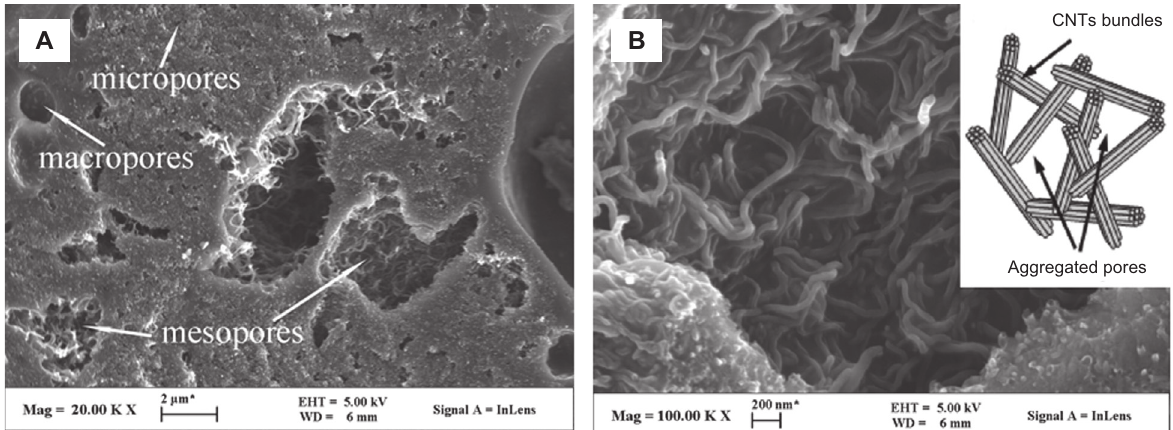
Figure 8 (A) Scanning electron microscope morphology of the composite spheres and (B) image of the aggregated pores of CNTs.